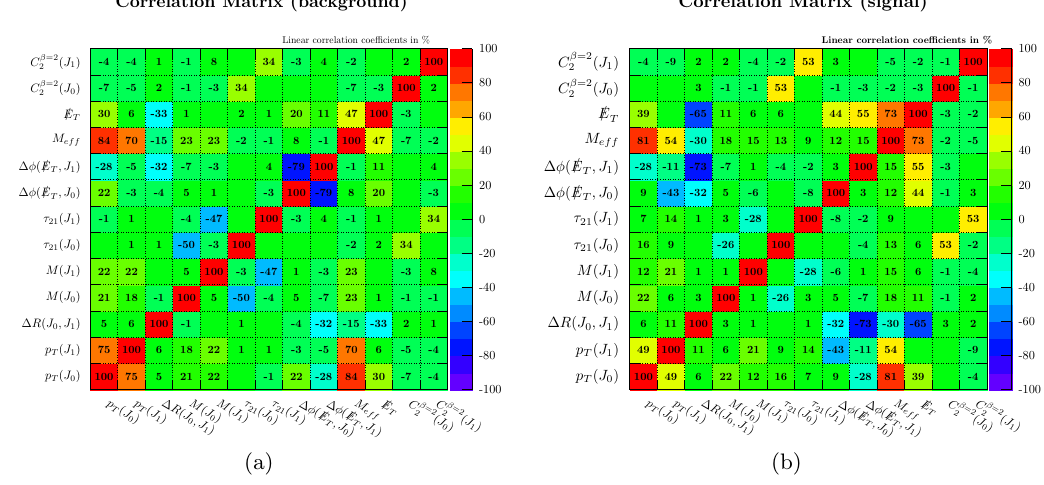
Figure 4 . The linear correlations coe(cid:14)cients (in %) for (a) signal and (b) background among di(cid:11)erent kinematical variables that are used for the MVA for benchmark point BP1 . Positive and negative signs of the coe(cid:14)cients signify that the two variables are positively correlated and negatively correlated (anti-correlated).